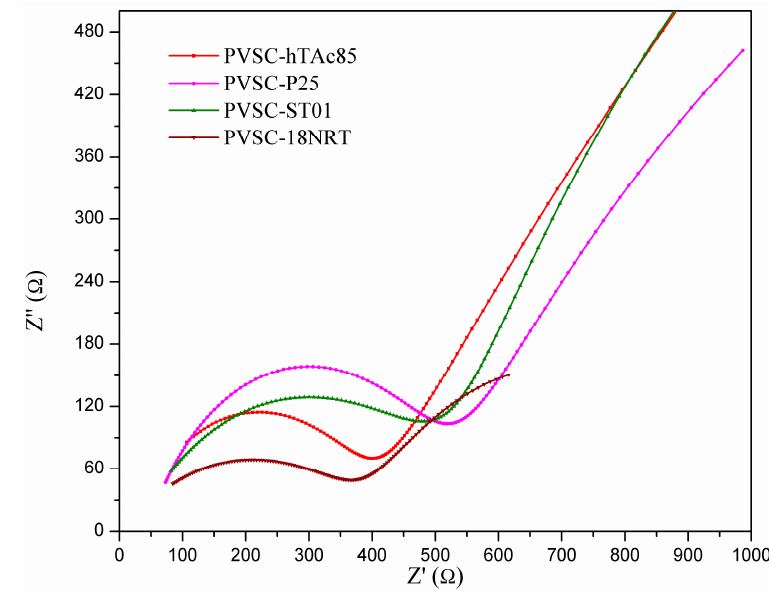
Figure 7. Nyquist plots of the electrochemical impedance spectra of PVSCs incorporating various kinds of TiO 2 in the active layer. Table 3. Photovoltaic characteristics of PVSCs incorporating different TiO 2 into the active layer (0.85-wt%).